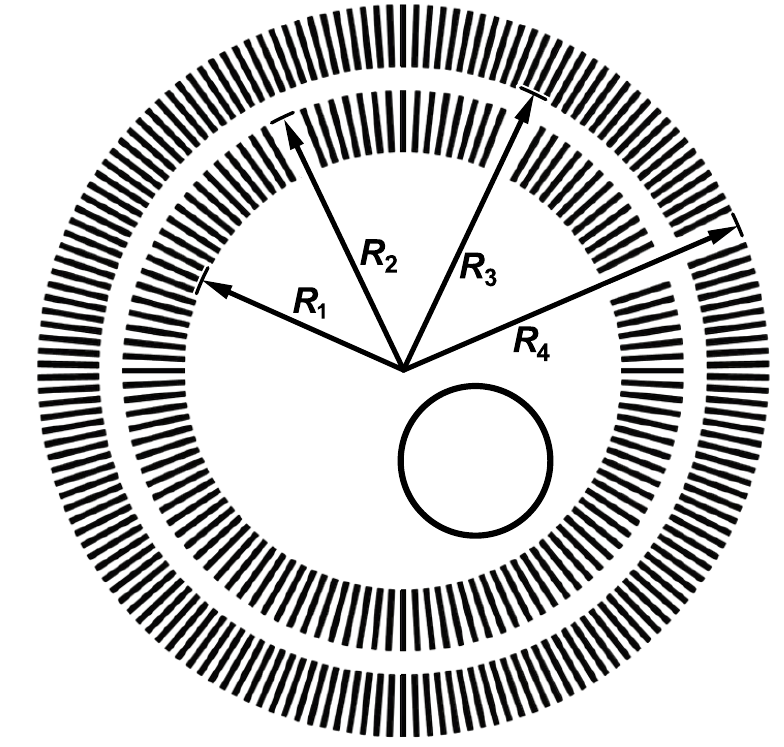
Figure 3. Highly simplified schematic of a cell with an outer monolayer membrane of thickness ( R − R ) and an inner monolayer membrane of thickness ( R 3 4 thickness ( R 3 − R 2 )